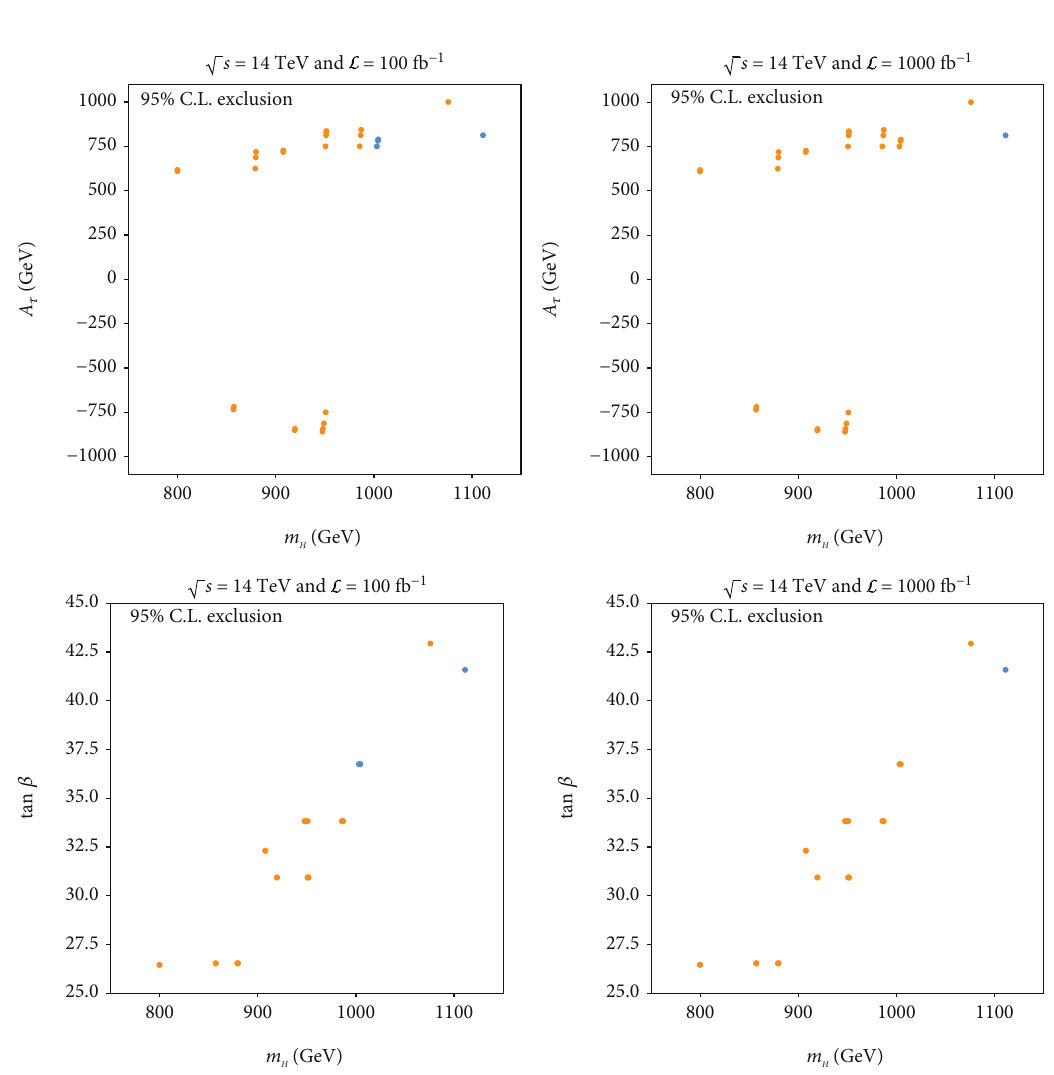
, A τ (cid:2) plane (a, b) and ½ tan β , A τ (cid:2) plane (c, d), within ffiffi p H = 14 TeV and total integrated luminosities of 100fb − 1 (a, c) and 1000fb − 1 (b, d). We s